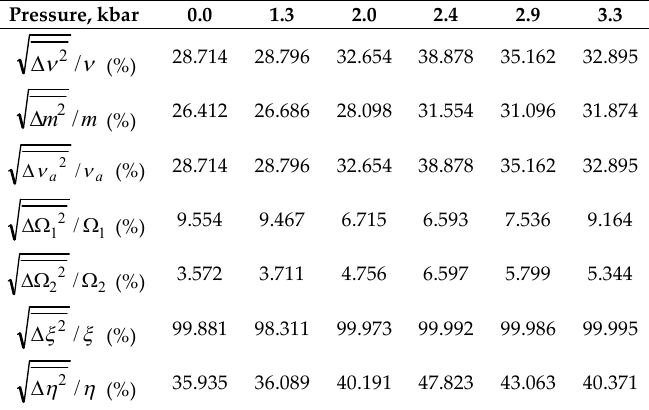
Table 9. Square roots of mean-square relative fluctuations of the distribution function parameters divided by the according parameters (in